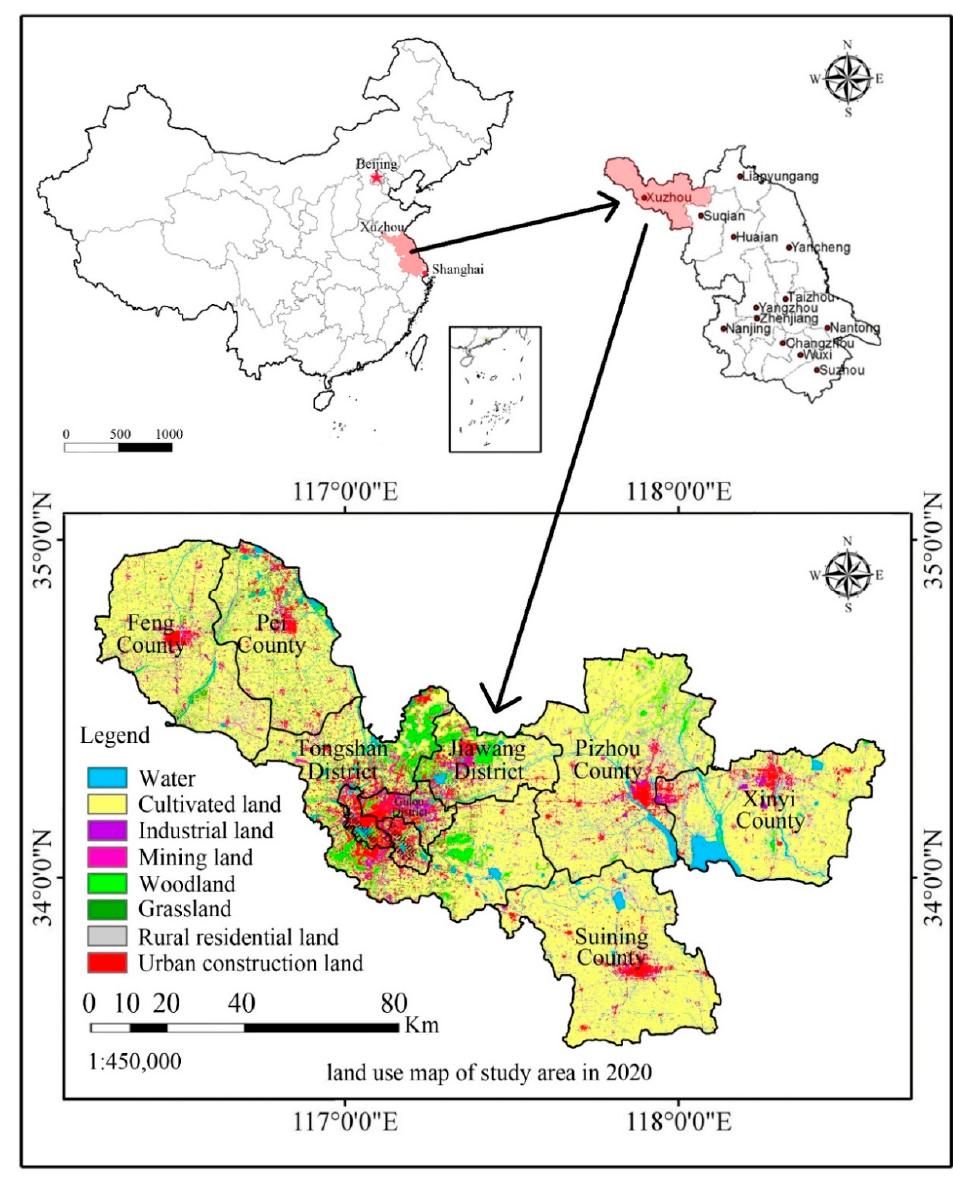
Figure 1. The geographical location and administrative divisions of Xuzhou in China.